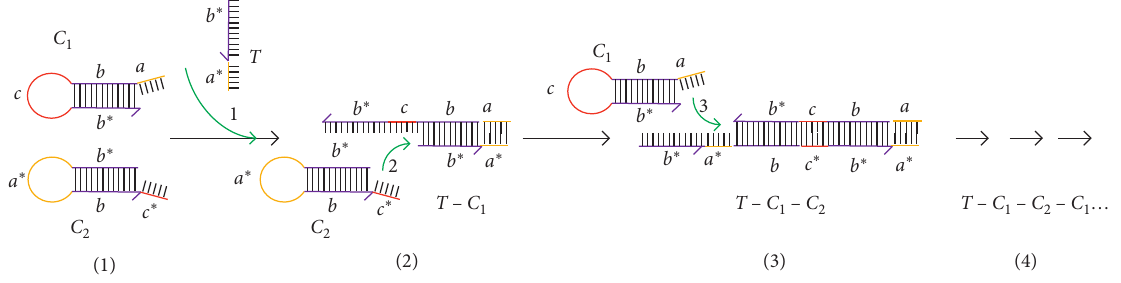
Figure 1: Basic principle of hybridization chain